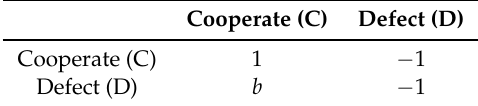
Table 1. A payoff matrix of Prisoner’s Dilemma game (PDG). b represents the temptation to